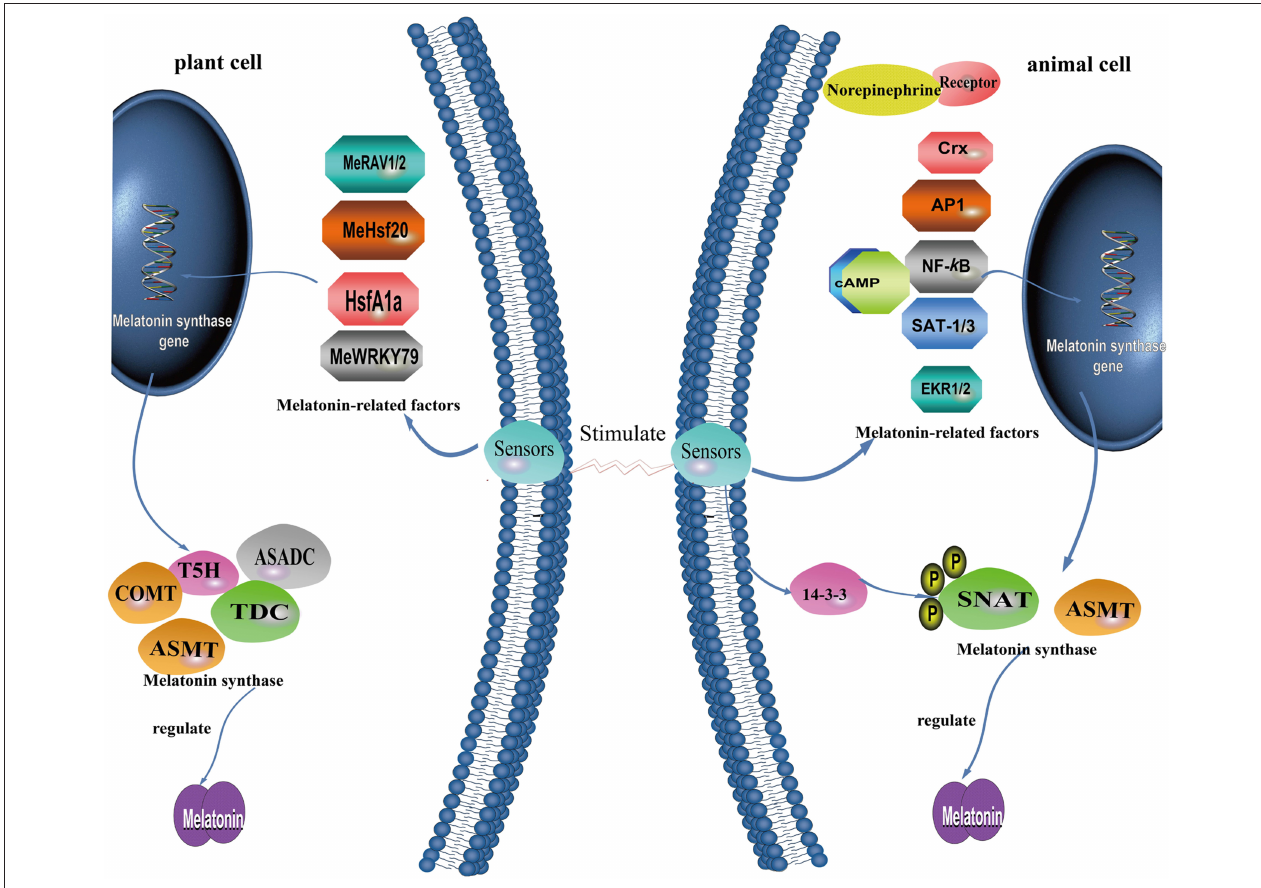
FIGURE 5 | A summary of what is known concerning the molecular mechanism governing melatonin production in plant cells and animal